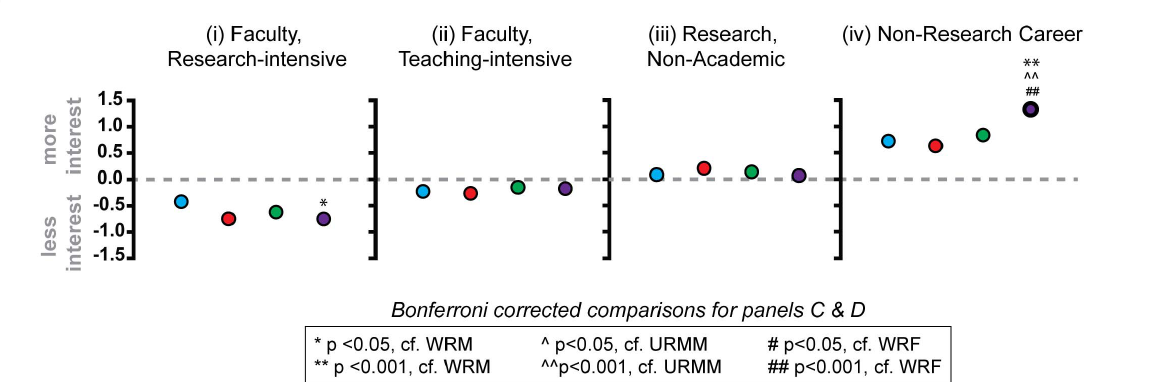
Fig. 1. Distinct career interest profiles among Ph.D. biomedical scientists by social identity. (A) Bar graph showing mean response for sample of 1500 American biomedical scientists who received Ph.Ds. between 2007–2012 when asked to rate their level of interest in each of the following career paths at Ph.D. entry (black), Ph.D. completion (grey), on a 5-point scale (where 1 represents ‘‘no interest’’ and 5 represents ‘‘strong interest’’): faculty at a research- intensive university; faculty at a teaching intensive university; a research career outside of academia (e.g. industry, pharmaceutical, biotech, government, start-up, etc.); and a non-research career (consulting, policy, science writing, patent law, business, etc.). (B) Pie chart showing the social identities of the respondents. Males from well-represented racial/ethnic backgrounds (WRM) are shown in blue and represent 25% of the sample; males from underrepresented minority backgrounds (URMM) are shown in red and represent 5.8% of the sample; females from well well-represented racial backgrounds (WRF) are shown in green and represent 53.9% of the sample; females from URM backgrounds (URMF) are shown in purple and represent 12.6% of the sample; and respondents declining to state racial/ethnic background or with an alternative gender identification are shown in grey and represent 2.7% of the sample. (C) Bar chart showing mean interest in the four career paths at Ph.D. entry, Ph.D. completion across social identity. Group